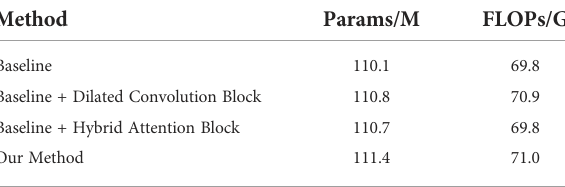
TABLE 2 Computational needs of our proposed method on BraTS 2020